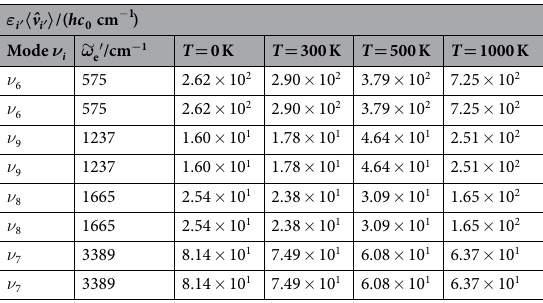
Table 2. Mean excitation wavenumbers of the components of individual vibrational e 2g symmetric modes of benzene as computed for different temperatures. The numbering used for the modes ν 6 , ν 7 , ν 8 and ν 9 , correspond to that used by Wilson for benzene and translates to ν 18 , ν 15 , ν 16 and ν 17 in Herzberg’s nomenclature, as computed in ref. 30 for the respectively. The corresponding harmonic vibrational wavenumbers ω ′  e electronically excited state and as used in the present calculations are also